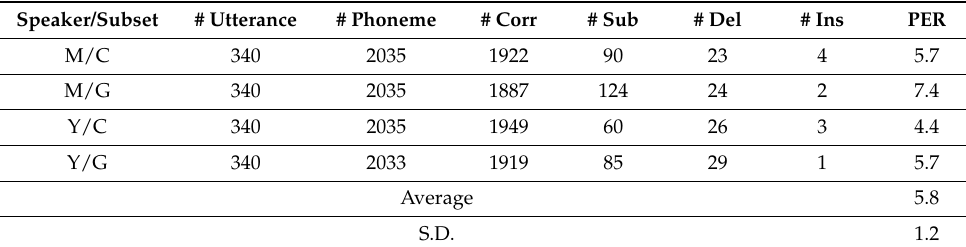
Table 8. Detailed analysis of the phoneme recognition results using the model